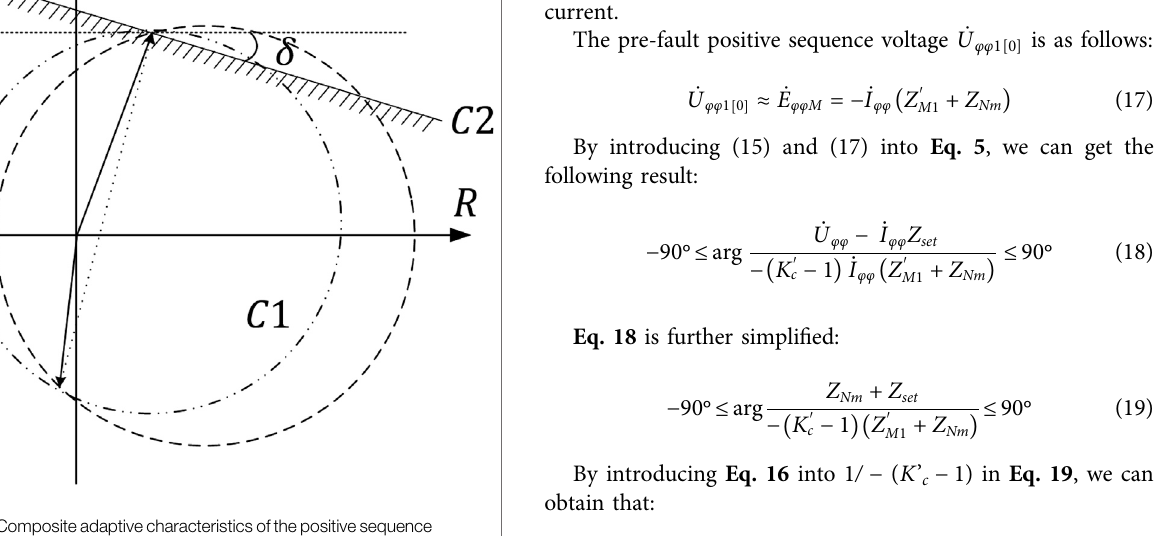
FIGURE4| Compositeadaptivecharacteristicsofthepositivesequence voltage fault component polarized impedance relay when forward fault